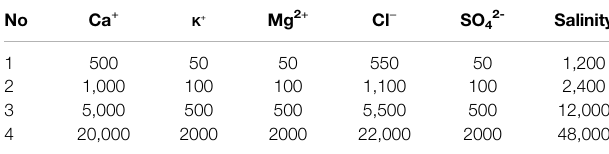
Figure 2 . The physical properties and experimental parameters of the sand packs are listed in Table 4 .